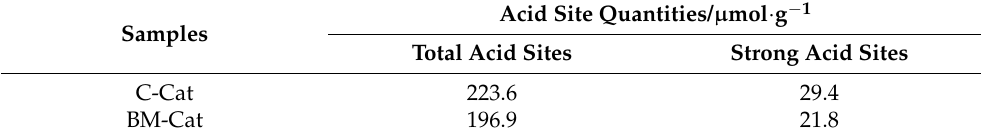
Table 3. Acid properties of FCC catalysts.